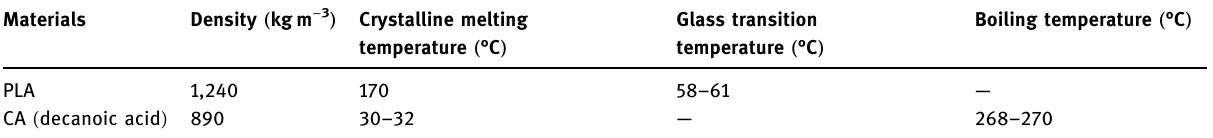
Table 4: Physical properties of PLA and of CA ( decanoic acid )